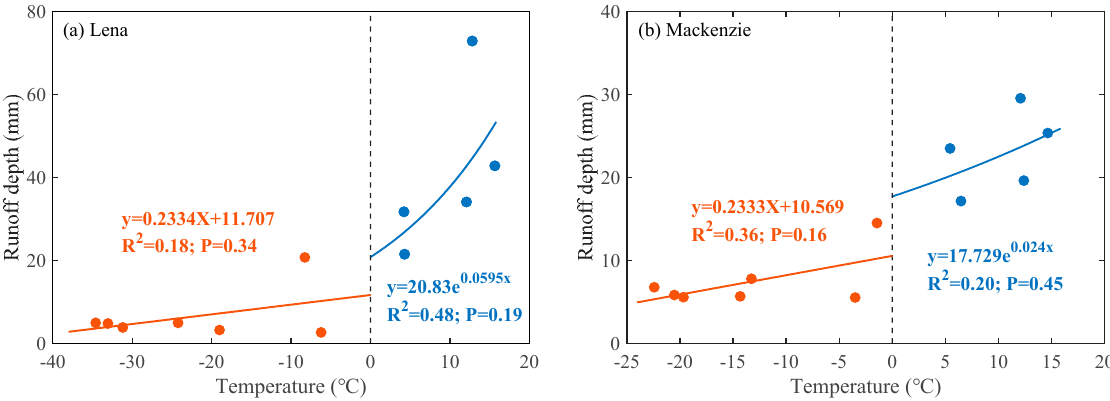
Figure 7. The relationships between the runoff and temperature in the LRB ( a ) and MRB ( b ) during 2003–2016.